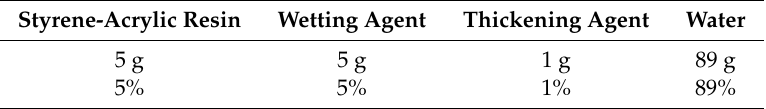
Table 4. Component composition of used pastes